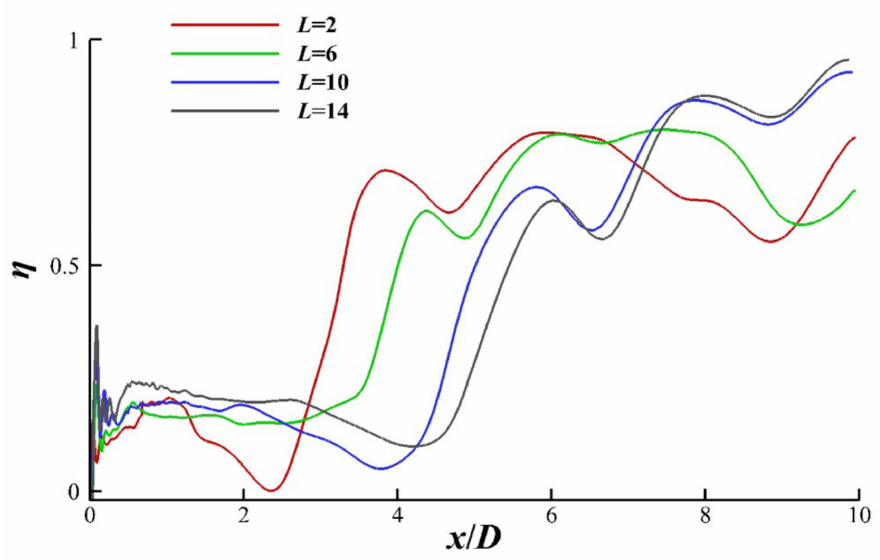
Figure 11. Velocity radial deficit at four positions: ( a ) x = 2.5 D , ( b ) x = 5 D , ( c ) x = 7.5 D , and ( d ) x = 10 D .